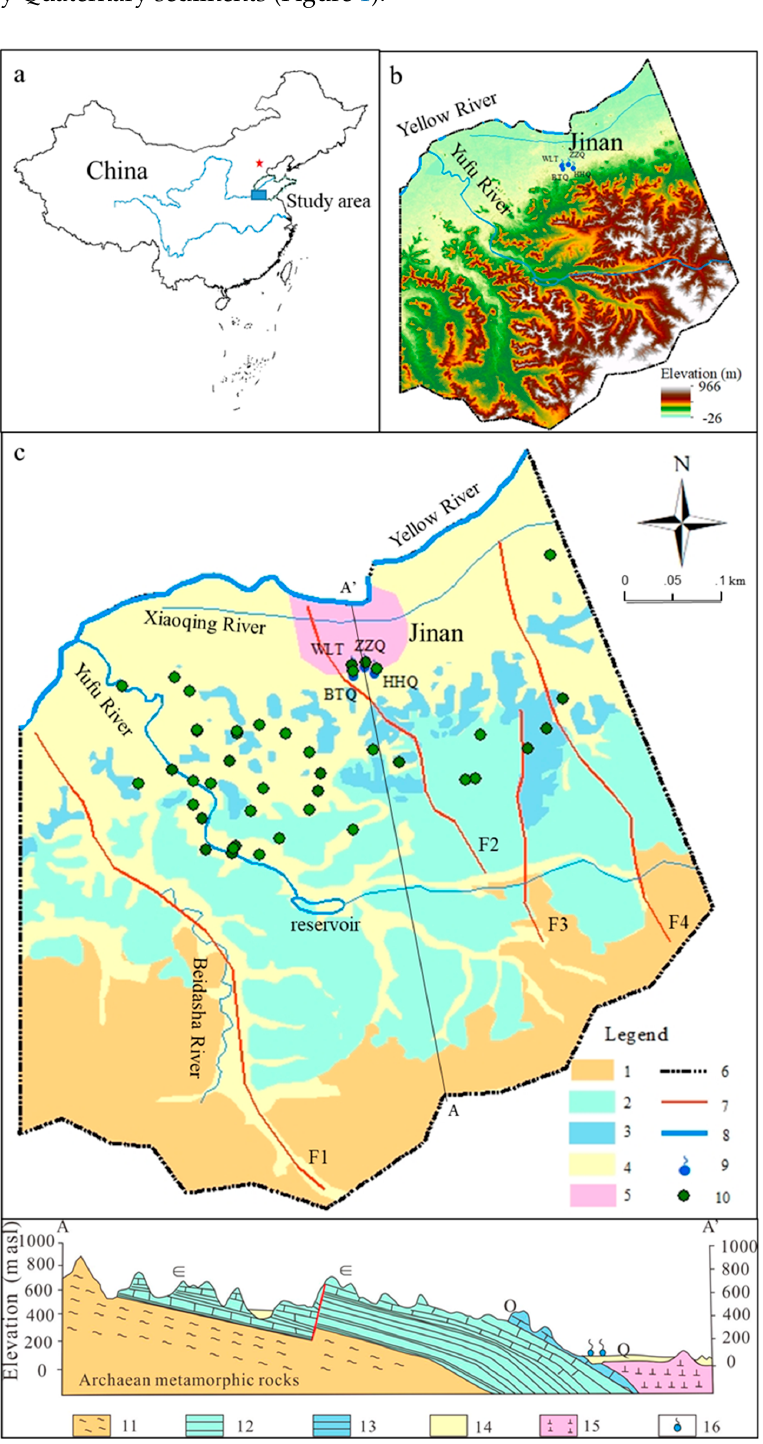
Figure 1. Location, sampling sites and hydrogeological map of Jinan karst system. ( a ) Location of the study area, ( b ) Topographic map of the study area. ( c ) Hydrogeological map of the Jinan karst system. (1, 11: Archaean metamorphic rocks; 2, 12: Cambrian limestone; 3, 13: Ordovician limestone; 4, 14: Quaternary sediments; 5, 15: magmatic rocks; 6: the range of study area; 7: fault; 8. river; 9, 16: spring; 10: sampling sites. A-A’ in Figure c: geological cross section)